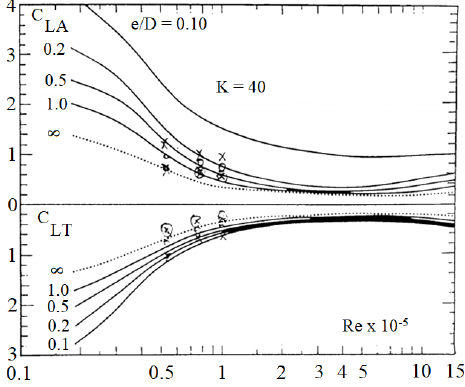
Figure 20. The flow pattern at t = 120, and the force coefficients for G/D = 0.1, Kc = 40 and Re = 25,000.